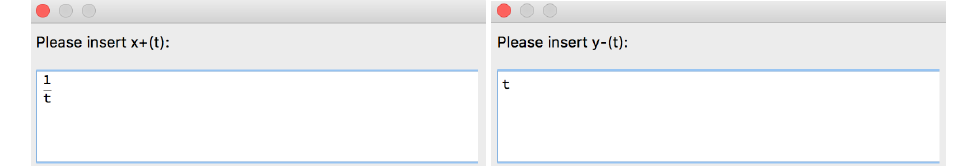
Figure 19. Part of the structure of the [SInt] algorithm corresponding to the input of x + and y − .